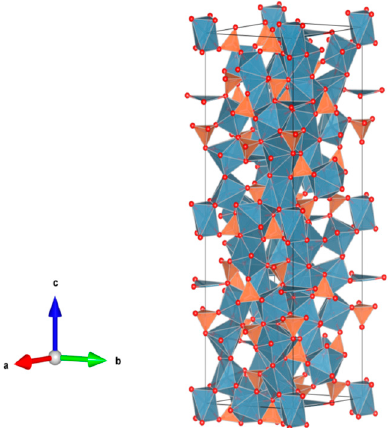
Figure 28. Whitlockite. Ca 3 (PO 4 ) 2 . Structure trigonal, Sp. gr. R3c.Cations can be H, Li, Na, K, Cu, Mg,